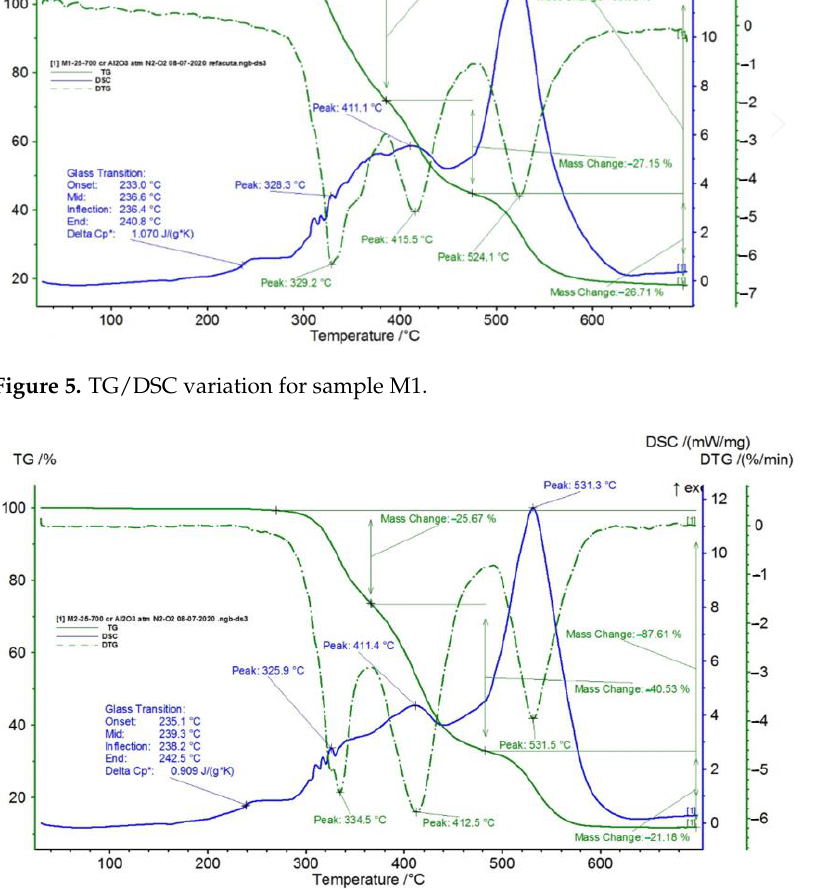
Figure 7. TG/DSC variation for sample M3. Figure 8. TG/DSC variation for sample M4.